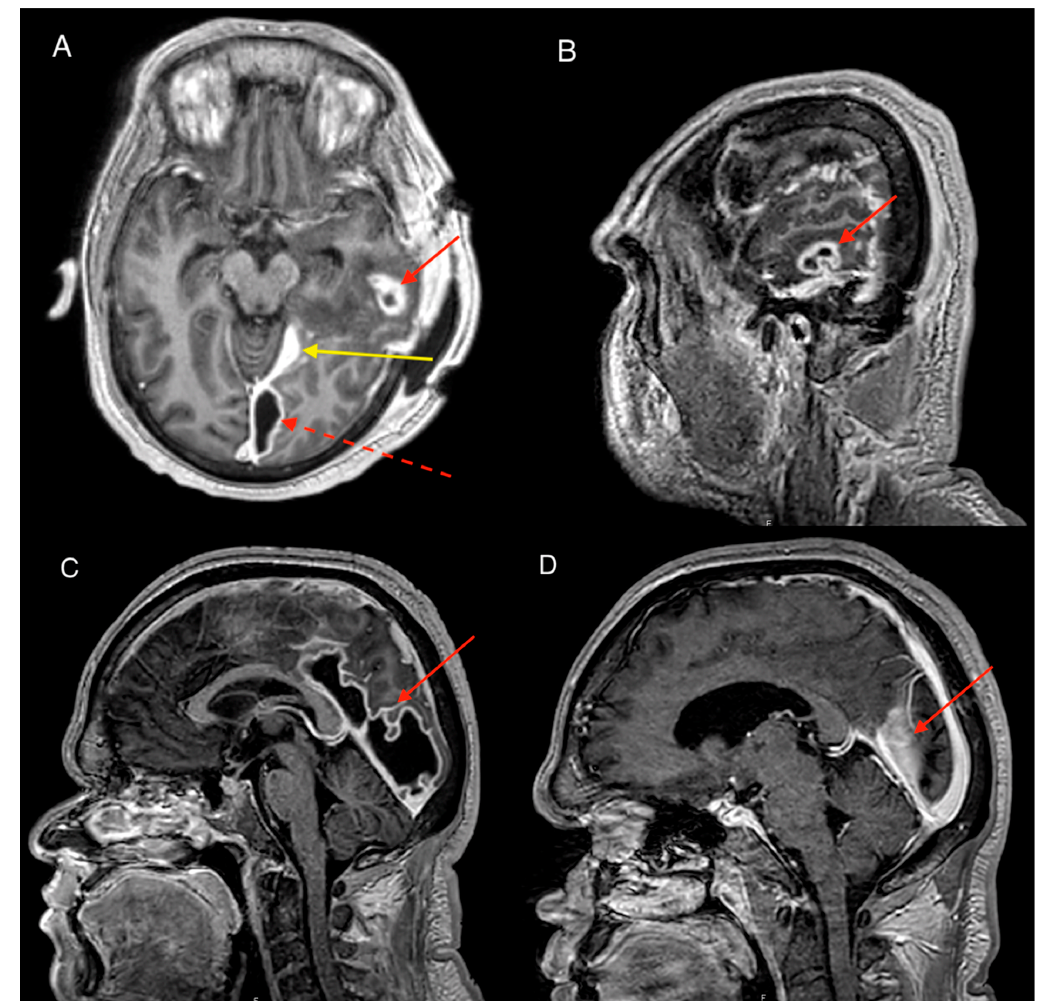
Figure 3. MRI brain with contrast. (A & B) Axial and sagittal scans after first surgery illustrating development of intracerebral abscess (red arrow) and development of parafalcine collection (dotted arrow). Note dural thickening and enhancement of the tentorium (yellow arrow). (C & D) Comparison MRI pre-operative to second surgery and then 4 weeks later showing complete resolution of collection in the parafalcine